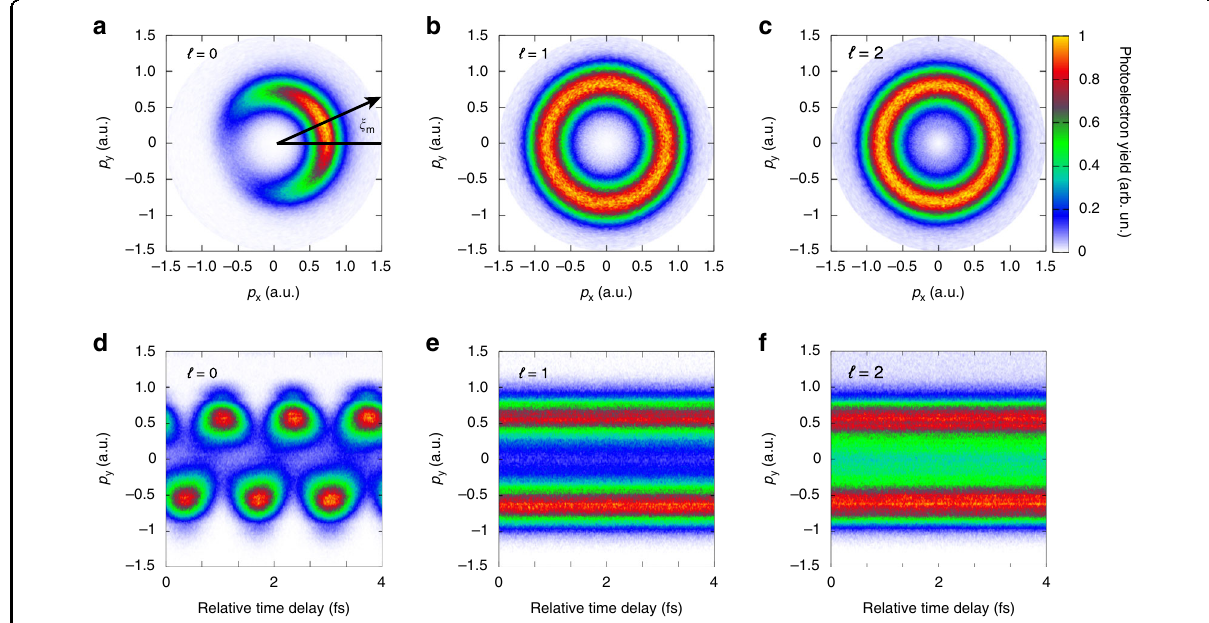
Fig. 2 Probing the OAM of intense vortex pulses with the non-spatially sculpted probing pulses in strong- fi eld ionization measurement. a – c Measured photoelectron momentum distributions by the two-color fi elds. d – f The sub-cycle time-dependent momentum distributions. The topological charges of the unknown light fi elds are ( a , d ) ℓ = 0, ( b , e ) ℓ = 1, and ( c , f ) ℓ = 2,